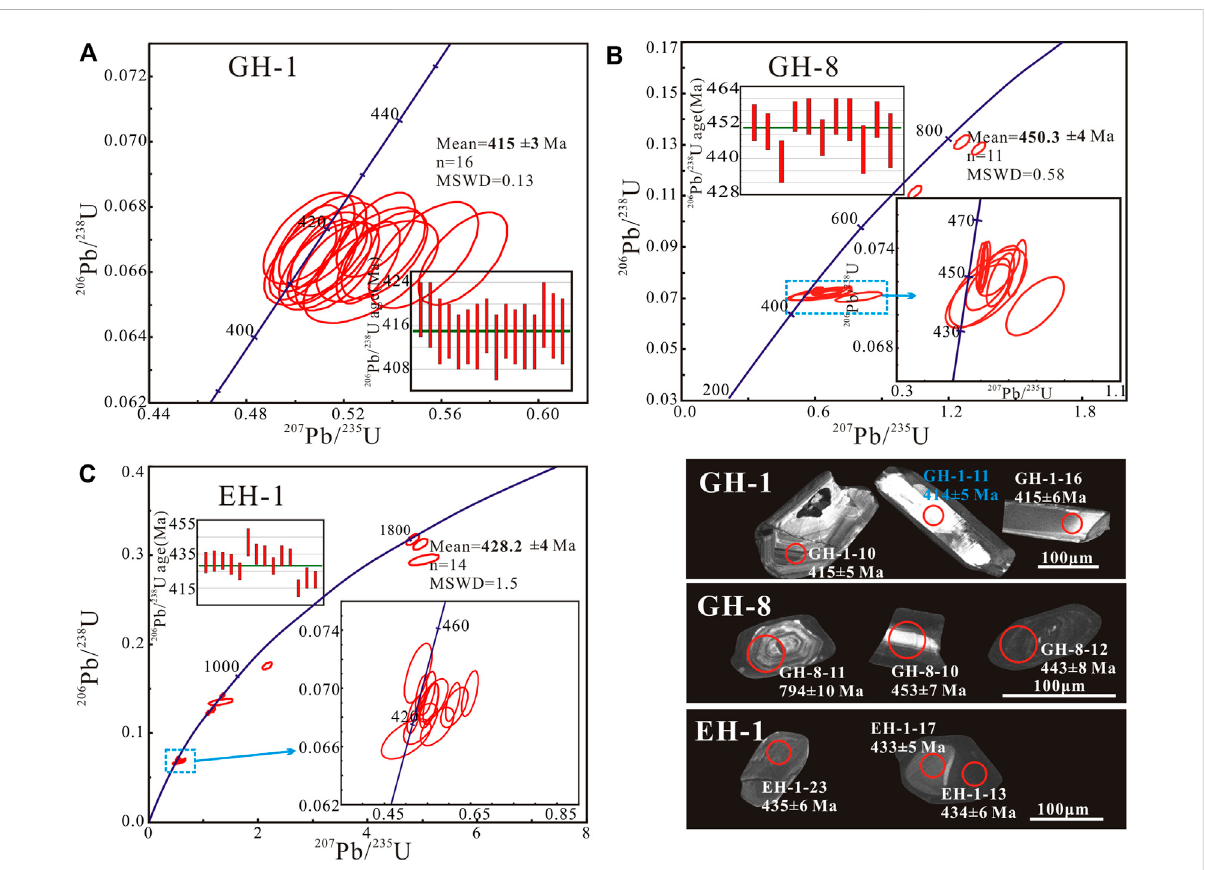
FIGURE 4 Representative CL images and U – Pb concordia diagrams for granodiorite (A) and biotite granite (B) within the Gahai pluton and muscovite- bearing granite (C) within the Erhai pluton.